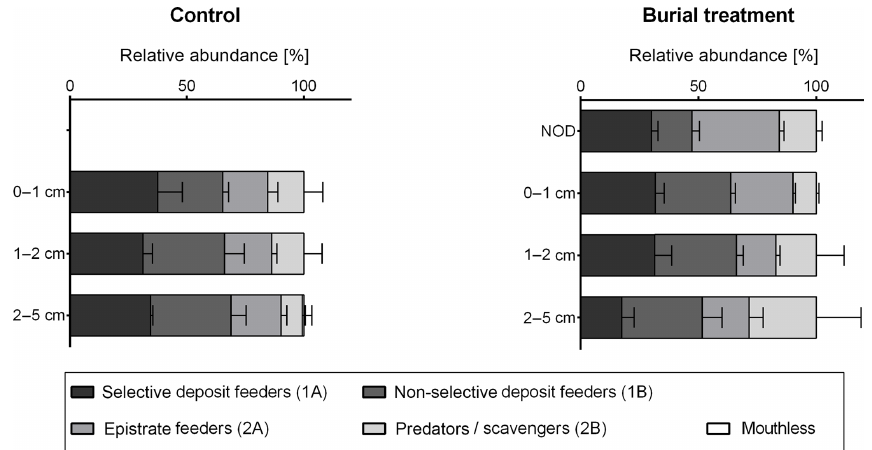
Figure 7. Vertical profile of the relative abundance of nematode feeding types per sediment depth layer (percentage + standard error) in the Control and Burial treatment with a ± 2cm layer of crushed nodule particles (NOD).